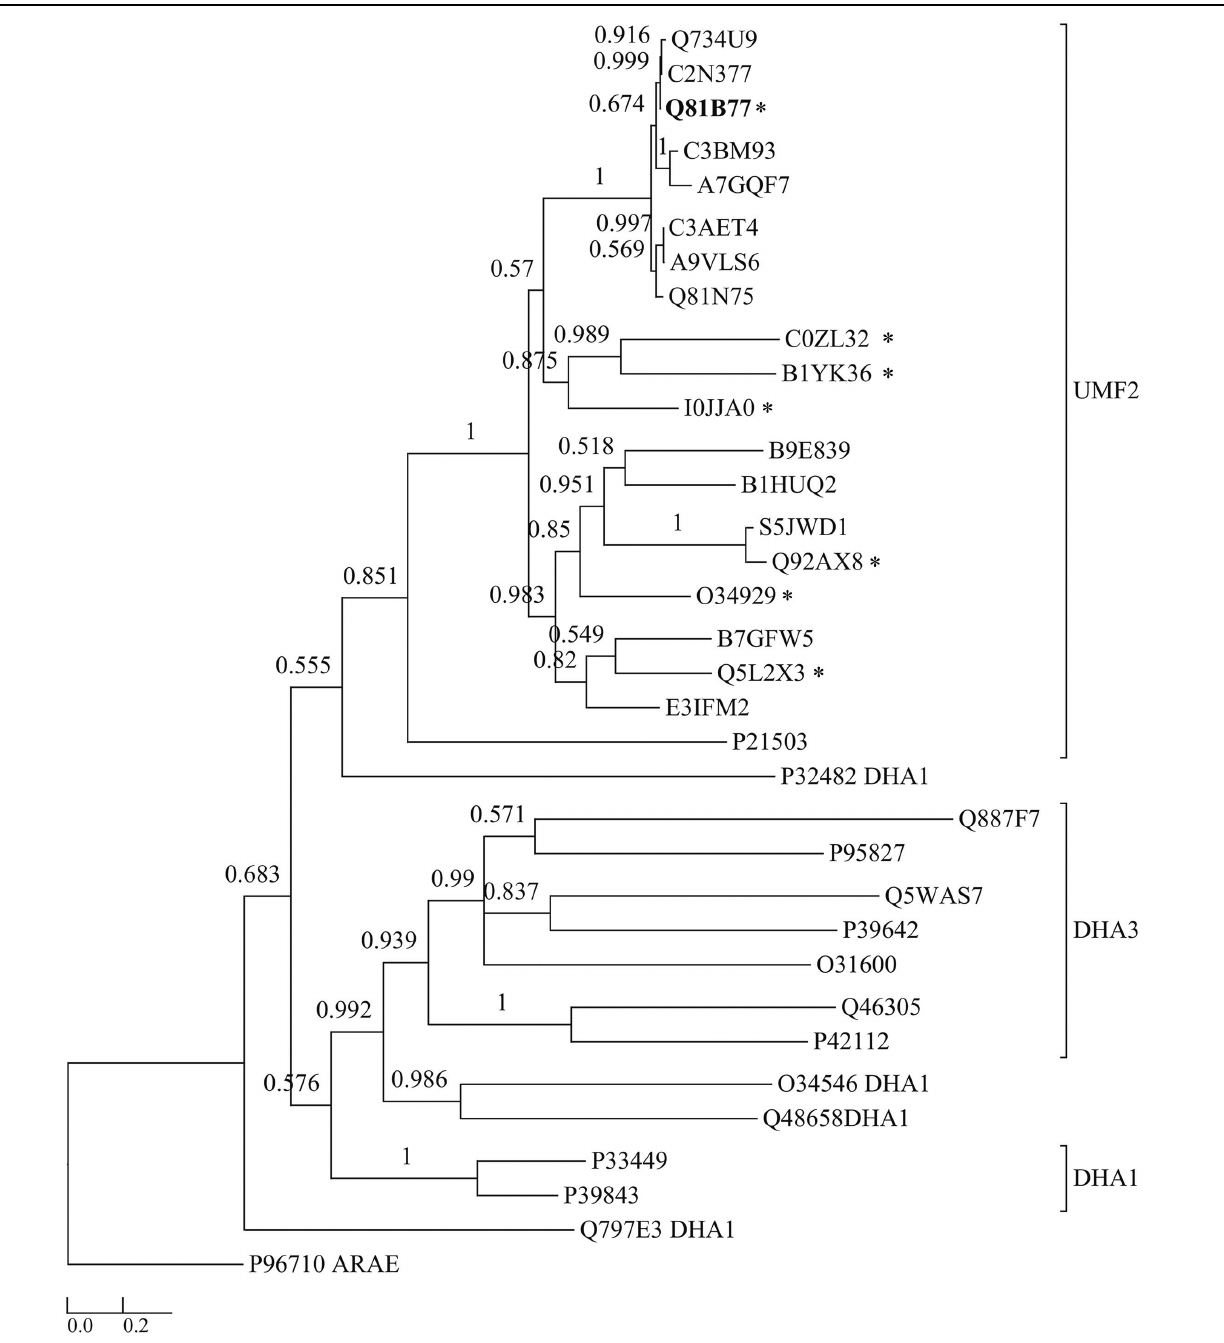
Frontiers in Microbiology | www.frontiersin.org